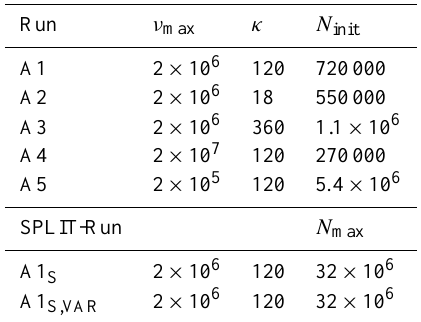
Table 2. List of parameter values used in the deposi- tion/sublimation/sedimentation sensitivity study in Sect. 3.1. Max- imal number of ice crystals represented by a SIP ν max , the number of bins κ and the resulting total number N init of initialised SIPs. For the runs with the SPLIT technique the maximum SIP number N max is